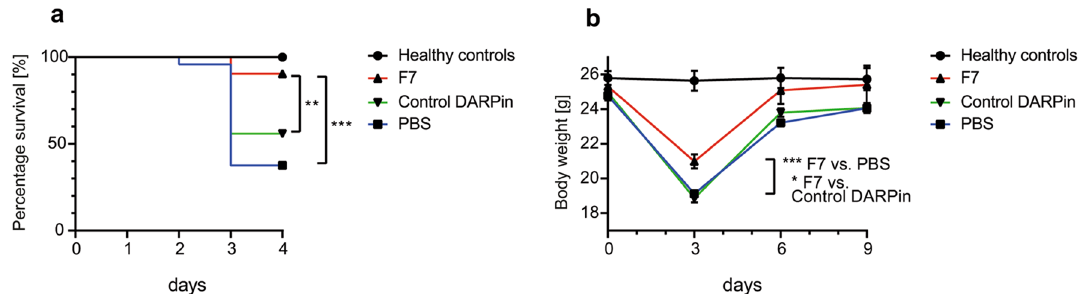
Figure 2. Treatment with F7 improves survival and reduces weight loss during the acute phase in a mouse model of acute lung injury. ( a ) Kaplan–Meier plot indicating percentage of survival on different days during the acute phase. Terminally ill animals were euthanized according to the study protocol (Table 1). Probability of survival was calculated by dividing the number of surviving mice by the number of total mice (acute and chronic phase) and multiplying the result with 100%. The survival probability was significantly increased for mice treated with F7 compared to the PBS or the control DARPin groups. Data are presented as mean ±